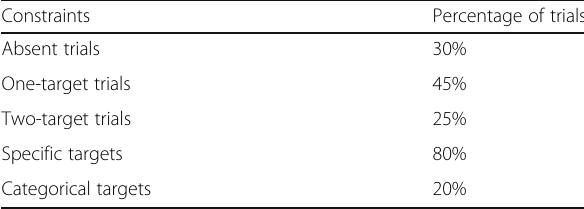
Table 1 The constraints on trials in Experiment 3 Constraints